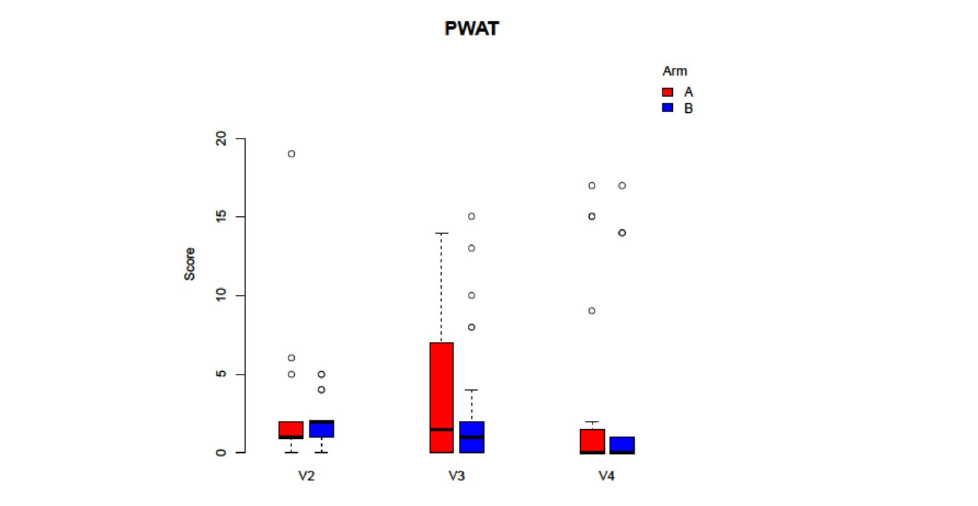
Figure 4. Analysis of the PWAT score did not display any statistically significant differences between the study arms (Arm A: − PRF, Arm B: +PRF, V2 p = 0.222, V3 p = 0.504, V4 p = 0.3017).